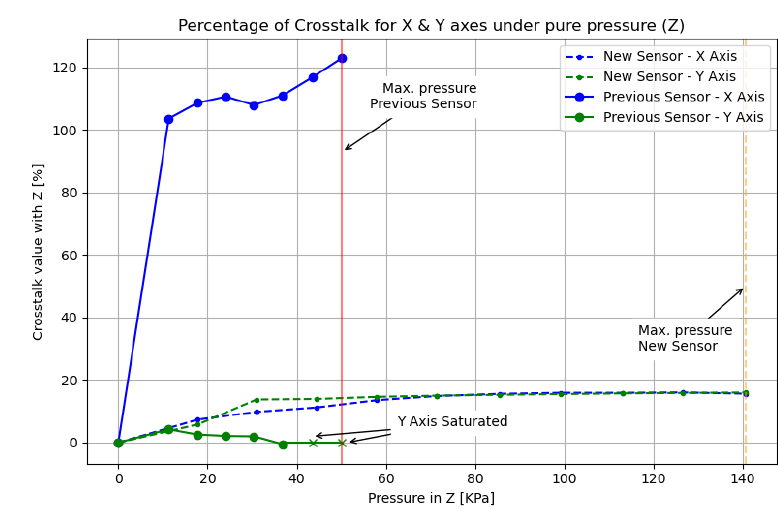
Figure 9. Crosstalk comparison: percentage of crosstalk from X - Y with relation to pure normal pressure ( Z